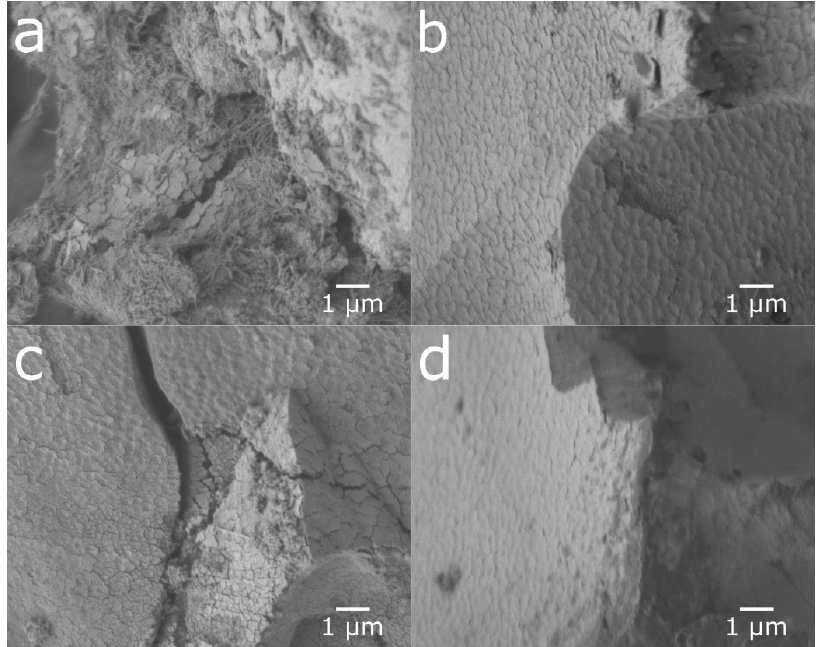
Figure 11. SEM secondary electron images at 10,000 times magnification. Acid-treated samples of cycled anodic material: ( a ) untreated, ( b ) 0.05 M H 2 SO 4 for 1 min, ( c ) 0.1 M H 2 SO 4 for 1 min, ( d ) 1 M H 2 SO 4 for 1 min.